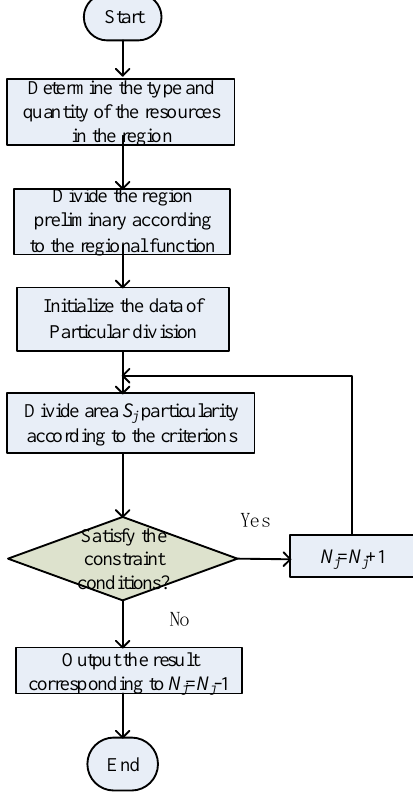
Figure 2. Flow chart of decision area division of VPP.